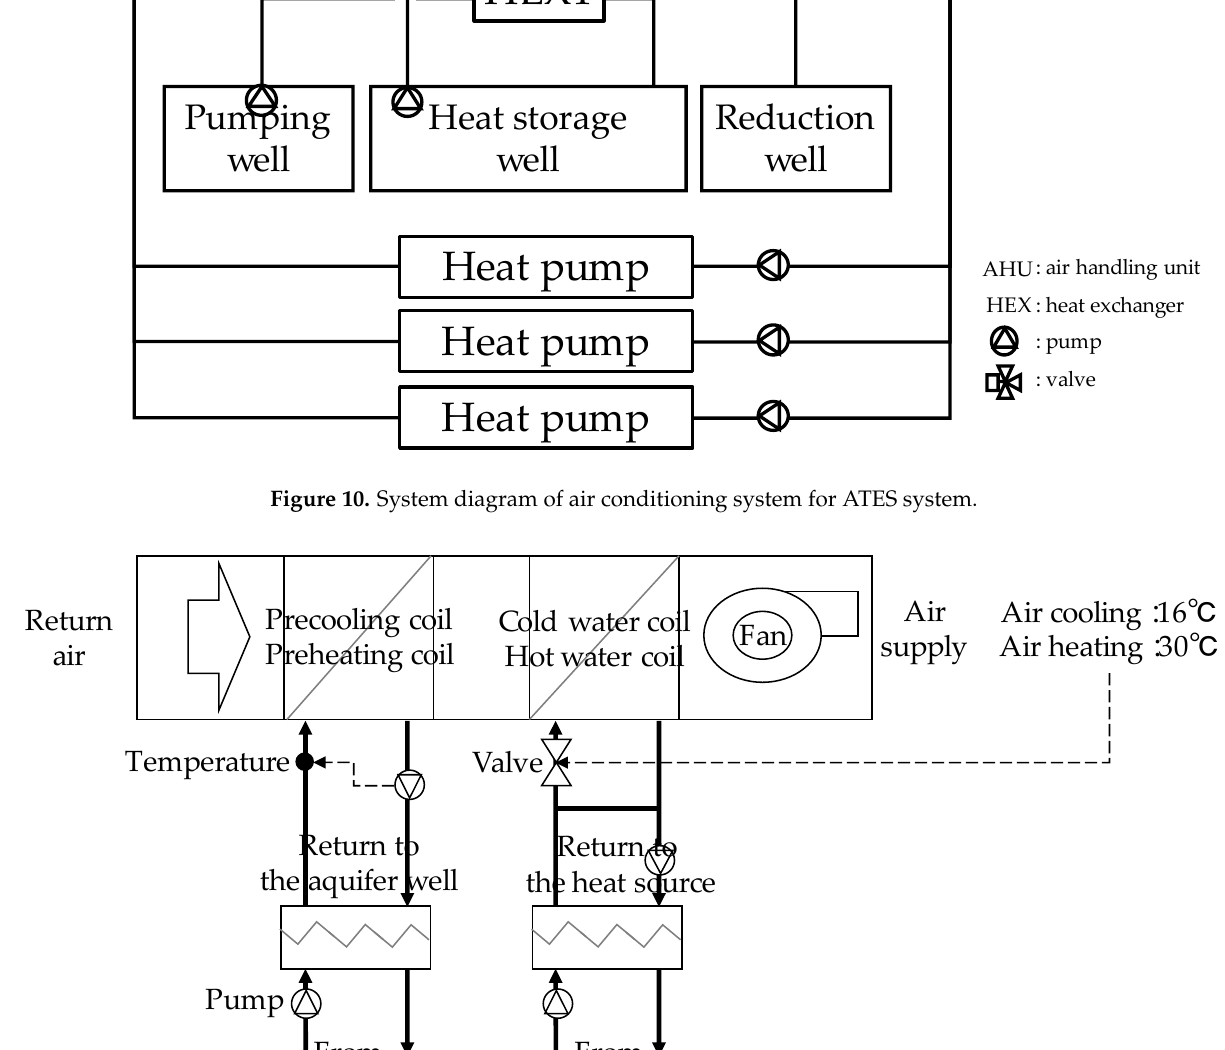
Figure 11. System diagram of AHU for ATES system.